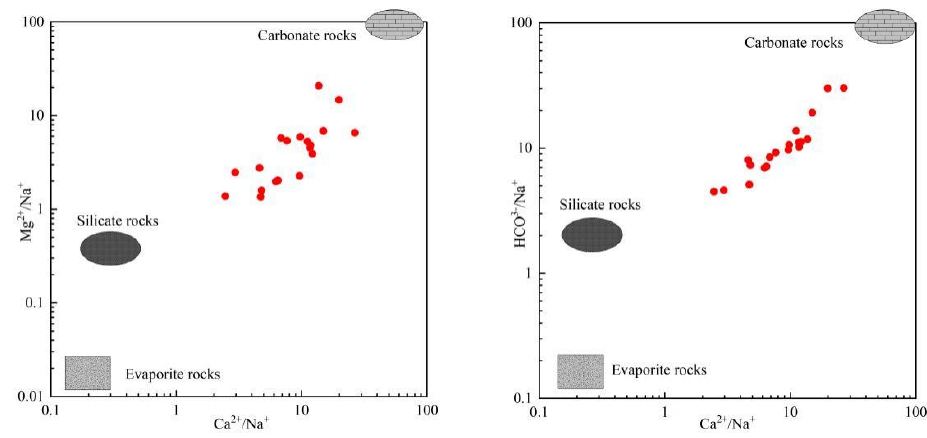
Figure 5. Relative contribution of weathering and dissolution of rocks.